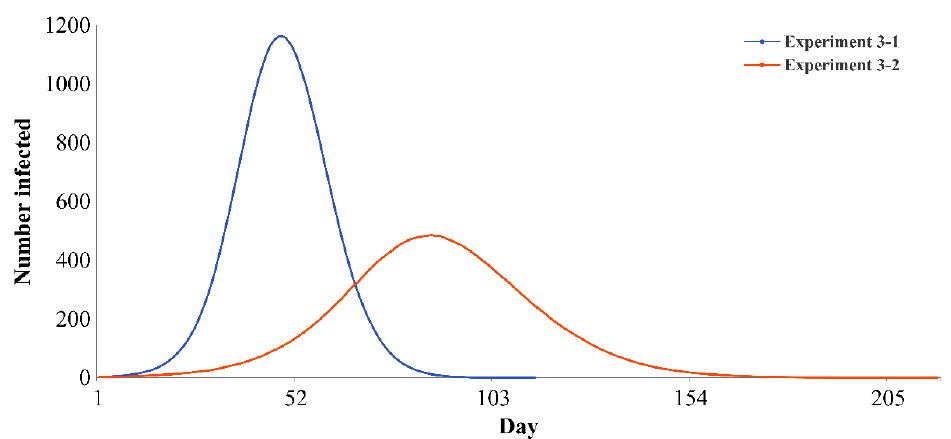
Figure 5. Infection curves of different intensities of the RGOUT policy (the other policies are strict).